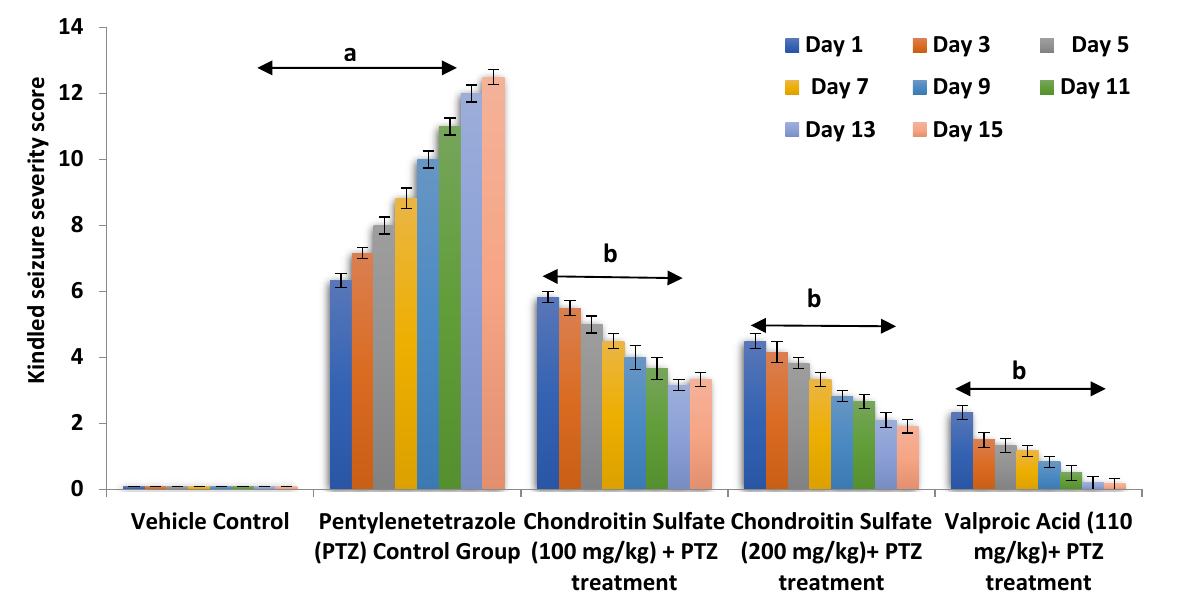
Figure 3. Antiepileptic effect of CS on PTZ-induced alteration in kindling severity score in mice. Values are expressed as mean ± SEM; a p < 0.01 vs. vehicle control; b p < 0.05 vs. PTZ